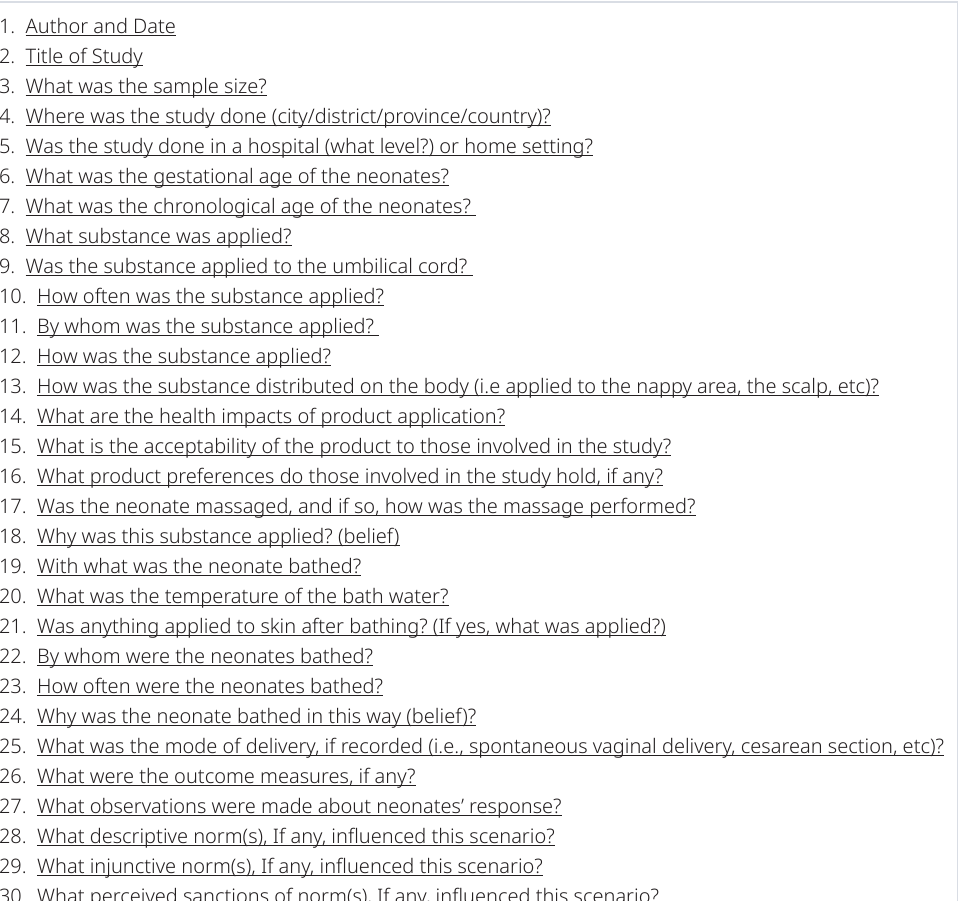
Table 2. Guiding queries used to electronically capture relevant information from each included